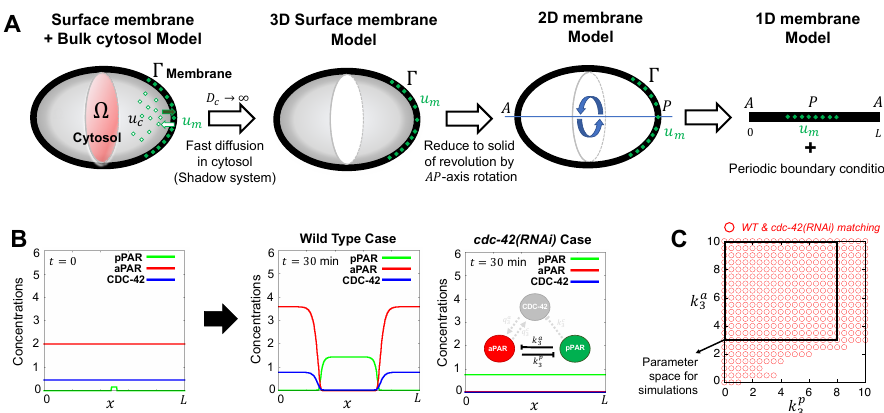
Figure 2. Schematic of model components and geometry. ( A ) Model reduction from three dimensions to one dimension in space. A cross section of the bulk cytosol region is coloured by red, the surface is coloured by gray, with u c , u m denoting generic cytosolic and membrane densities, respectively. Fast cytosolic diffusion timescales compared to the timescales of interest lead to effectively homogeneous cytosolic concentrations, that can be captured by membrane concentrations via conservation principles, as discussed in Section 2.2. This allows the model to be reduced to membrane equations, with axisymmetry about the major axis of the cell for a simple geometry yielding the final simplification, as detailed in Appendix A.1. ( B ) Representative simulations for wild type case and cdc-42(RNAi) case. Simulations start with initial conditions given by initial conditions, Equation (5). After 30 min, the solutions shown have reached steady state. Here, and throughout the paper, concentrations are in units of M / L , where M is the characteristic protein number of Table A1, and L is the perimeter of the projected membrane in ( A ). ( C ) The range of values for the parameters k p , and k a that satisfy both wild type and cdc-42(RNAi) behaviours which serves as a validation of the 3 3 model against observations. The red circles indicate the parameter region matching both wild type and ) used for sensitivity cdc-42(RNAi) behaviours. The black square indicates the range of ( k p , k a 3 3